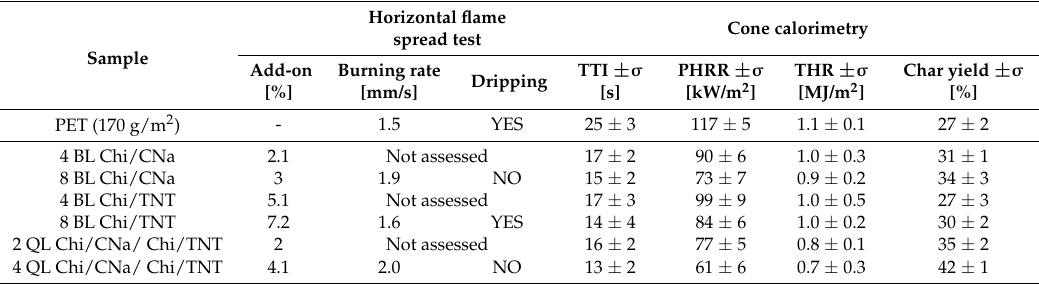
Table 10. Flammability and cone calorimetry (under 35 kW/m 2 ) data for PET treated by CNa- and TNT-based LbL coatings [46].